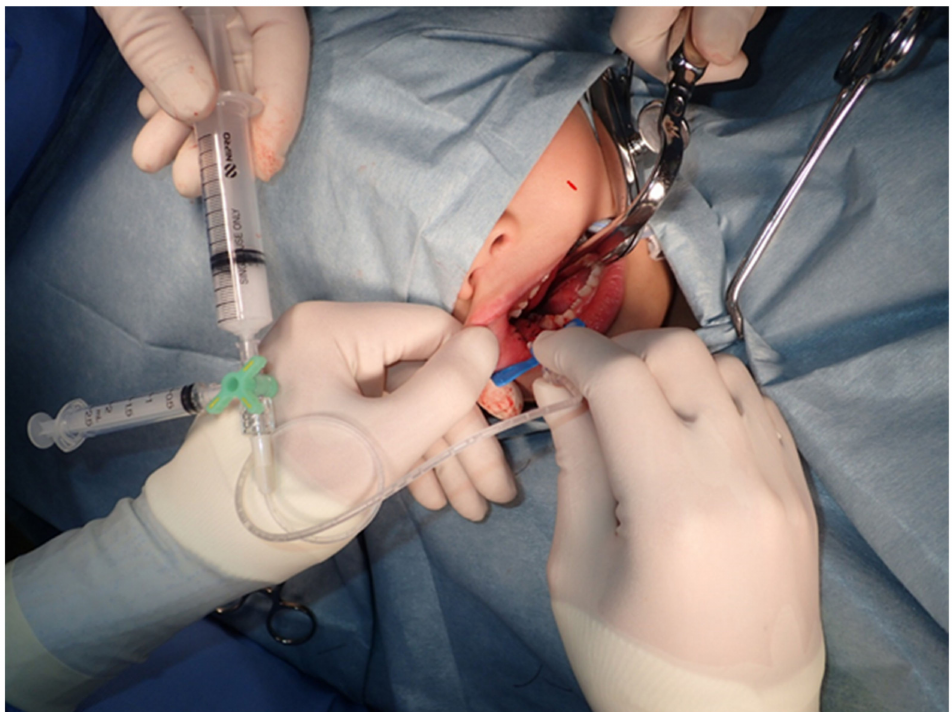
Figure 1. Injecting polidocanol using the foam